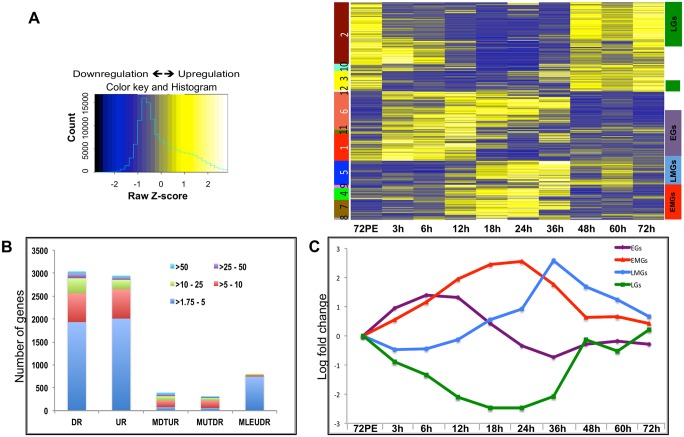
Expression dynamics of A. aegypti fat body genes post blood meal.(A) The heatmap shows the expression values (mean among three replicates) at nine different time points. Each row represents data from one transcript, and each column corresponds to a time point between 3 h and 72 h PBM. Hierarchical clustering with subsequent tree cutting identified 12 discrete clusters, which are color coded on the left. Clusters 1, 11 and 6 were grouped as EGs, clusters 8, 7 and 4 as the EMGs, cluster 5 carried the LMGs and clusters 2 and 3 were grouped as LGs. The color legend of the row-wise normalized expression values (Z-scores) is given on the left. (B) The stacked columns show the breakdown of the DEGs provided in Fig 1A and 1B –source data. The different colors represent the fold changes e.g. red signifies number of genes that were differentially expressed by >5 fold. DR—Down Regulated, UR—Up Regulated, MDTUR—More Down Than Up Regulated, MUTDR—More UP Than Downregulated, MLEUDR—More or Less Equally UP and Down Regulated. (C) Average expression profiles of all EGs (purple line), EMGs (red line), LMGs (blue line) and LGs (green line) shown, X- axis shows the different time points while the Y-axis displays the average log fold change (See S2 Dataset).